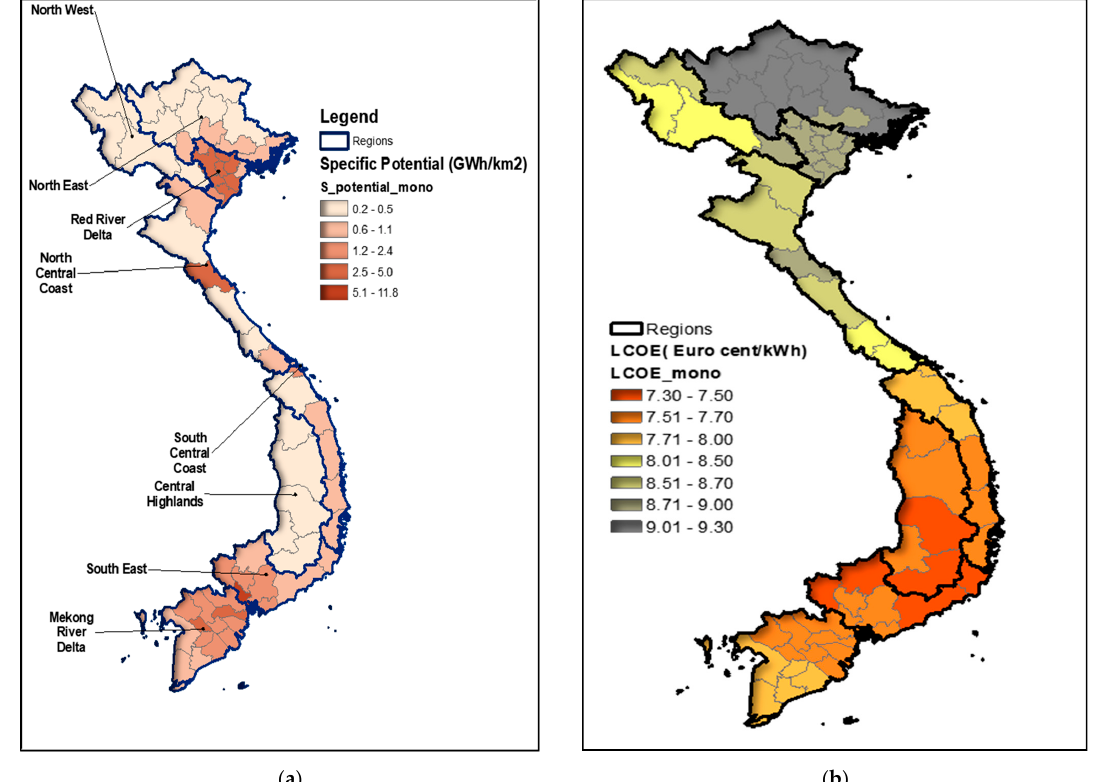
Figure 5. Maps of distributed electricity potential ( a ) and average LCOE ( b ) of rooftop PV by regions.